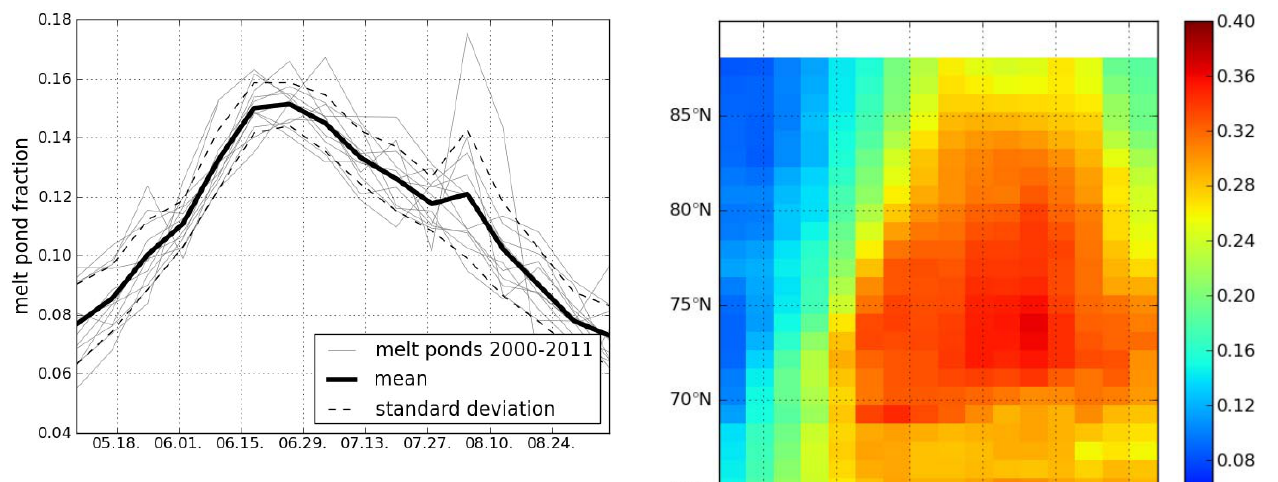
Fig. 6. Weekly mean melt pond fraction per grid cell over the en- tire Arctic Ocean from 2000 to 2011. The light gray lines display the single years, the solid black line is the average over the last 12 years. Data falling within one standard deviation of the mean are delineated by a pair of dashed lines.